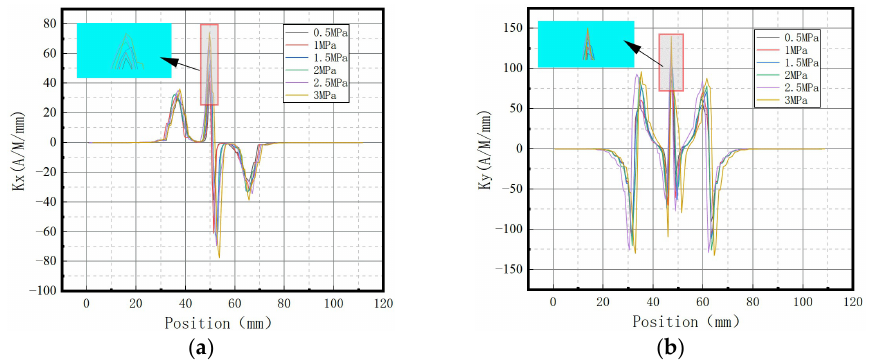
Figure 14. Magnetic signal gradient K at weld crack changes with internal pressures. ( a ) The axial gradient component Kx; ( b ) the radial gradient component Ky.